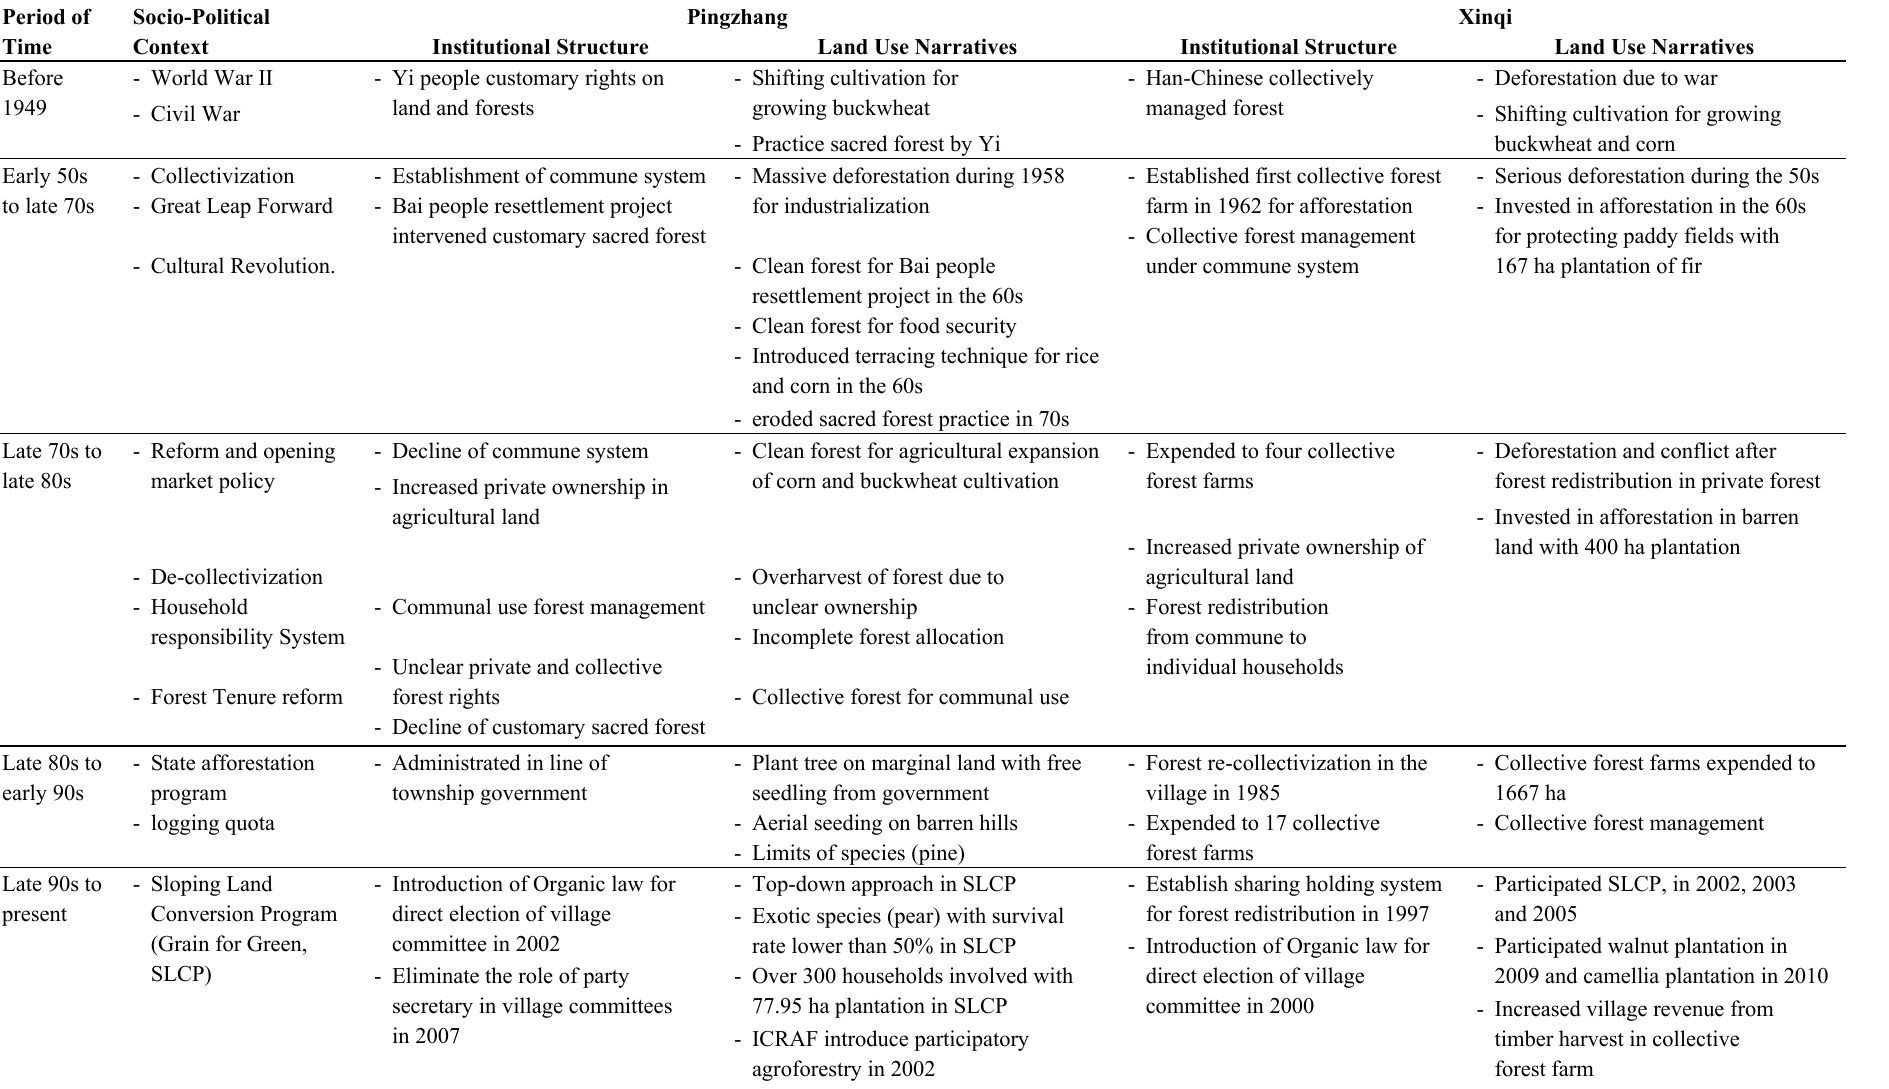
Table 3. Timeline of local institution and land use narratives in Pingzhang and